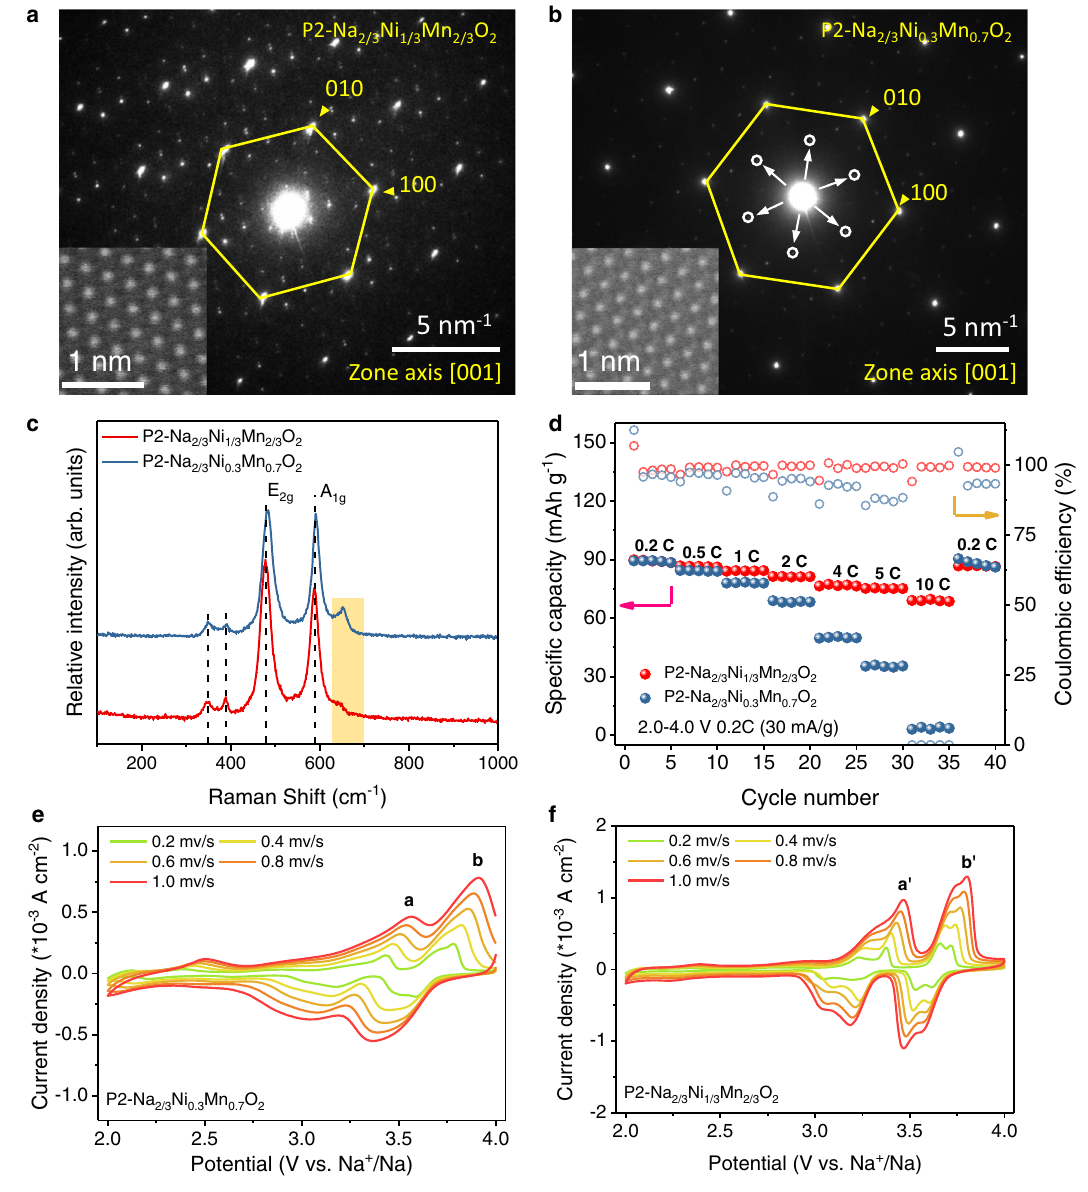
Fig. 2 | TEM and electrochemistry of the layered P2 phases. SAED patterns of a P2-Na 2/3 Ni 1/3 Mn 2/3 O 2 and b P2-Na 2/3 Ni 0.3 Mn 0.7 O 2 from [001] zone axis, and the correspondingSTEM-HAADFimagesalongthe[001]directionaredisplayed atthe